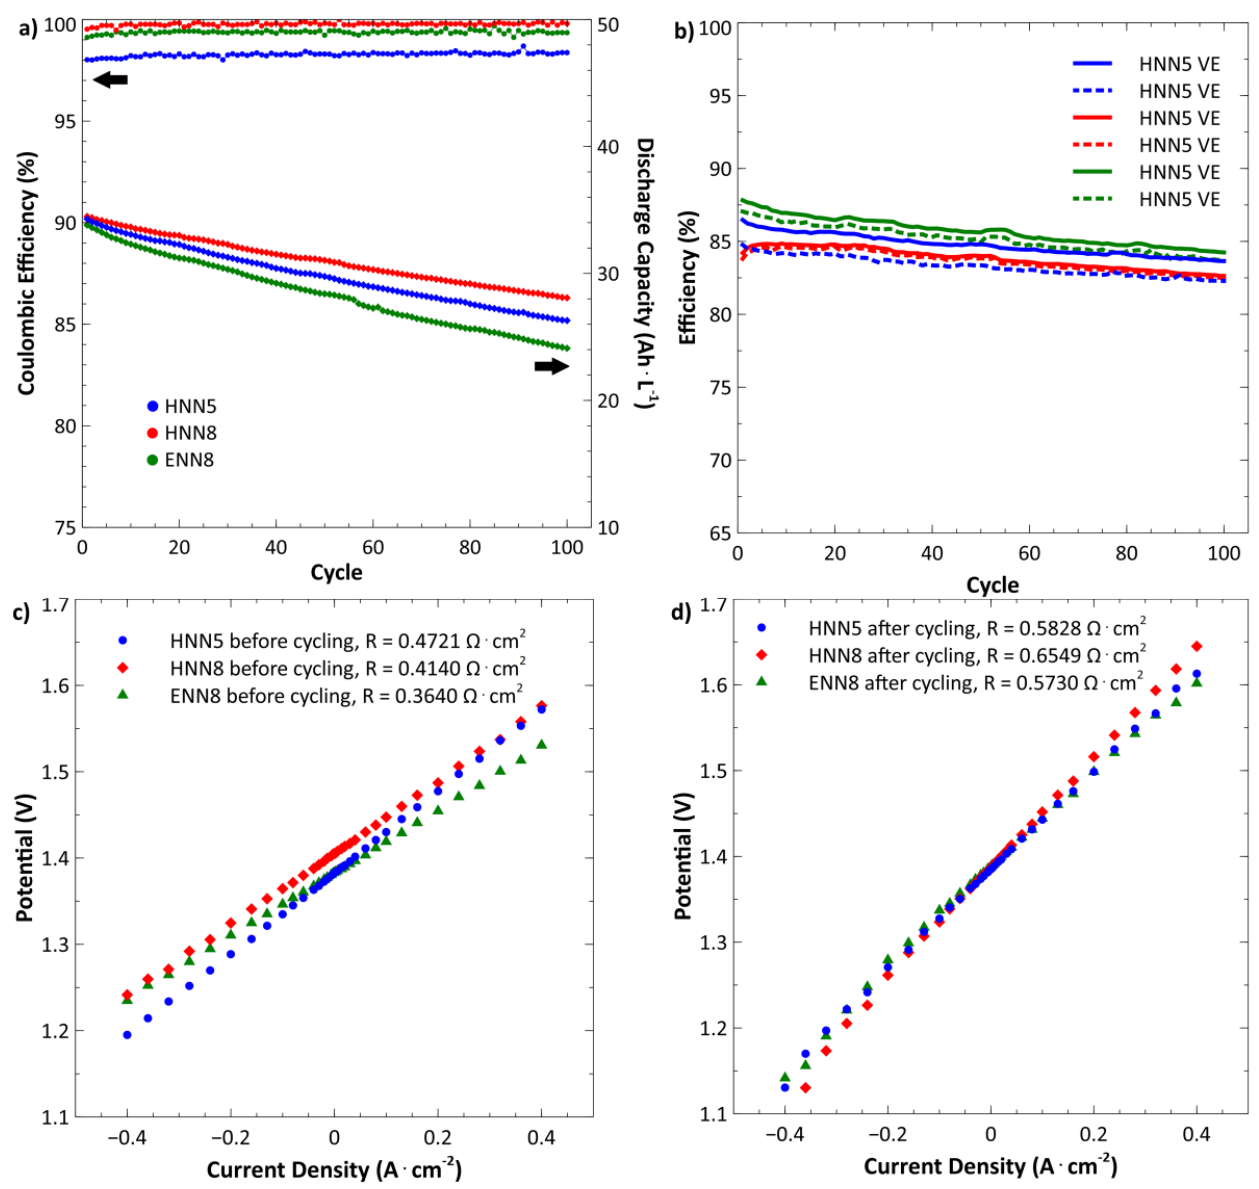
Figure 3. Charge/Discharge performance of the VRFB cell for HNN5, HNN8 and ENN8 membranes over 100 cycles showing ( a ) Coulombic Efficiency and Discharge Capacity, ( b ) Voltaic and Energy Efficiency, ( c ) Polarization curves prior to cycling, ( d ) Polarization curves after cycling. Experimental conditions: 1.6 M V(III) negative electrolyte, 1.6 M V(IV) positive electrolyte, both in 2 M H 2 SO 4 supporting electrolyte, constant current charging at 200 mA cm − 2 , 200 rpm (86 mL min − 1 ) flow rate and room temperature.